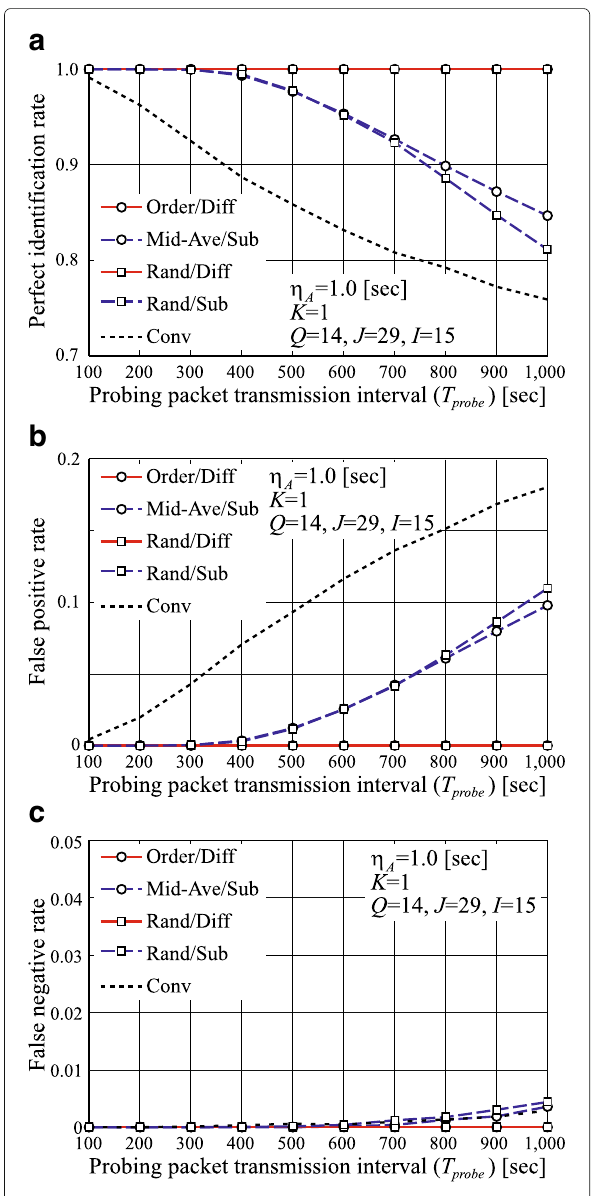
Fig. 7 Dependency on the probing packet transmission interval. a PIR, b FPR, and c FNR